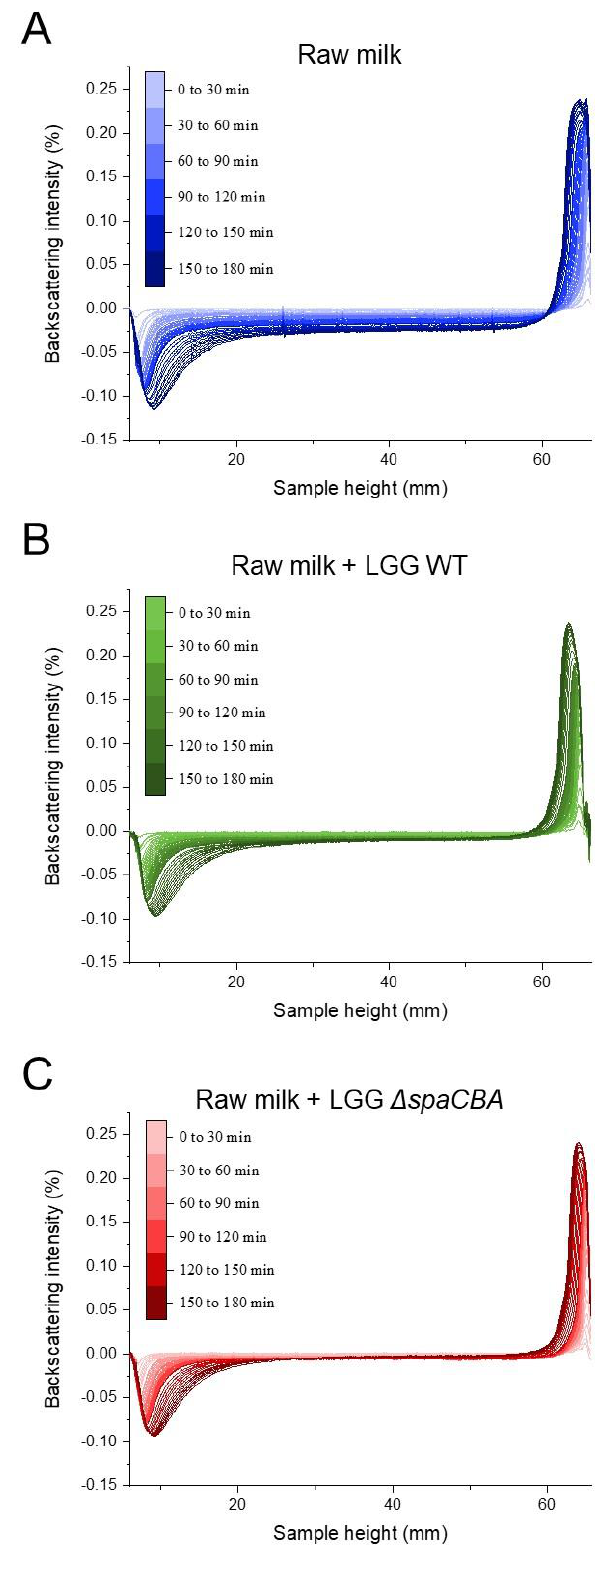
Figure 1. Backscattering intensity vs. sample height of ( A ) raw milk, ( B ) raw milk + LGG WT and ( C ) raw milk + LGG Δ spaCBA .